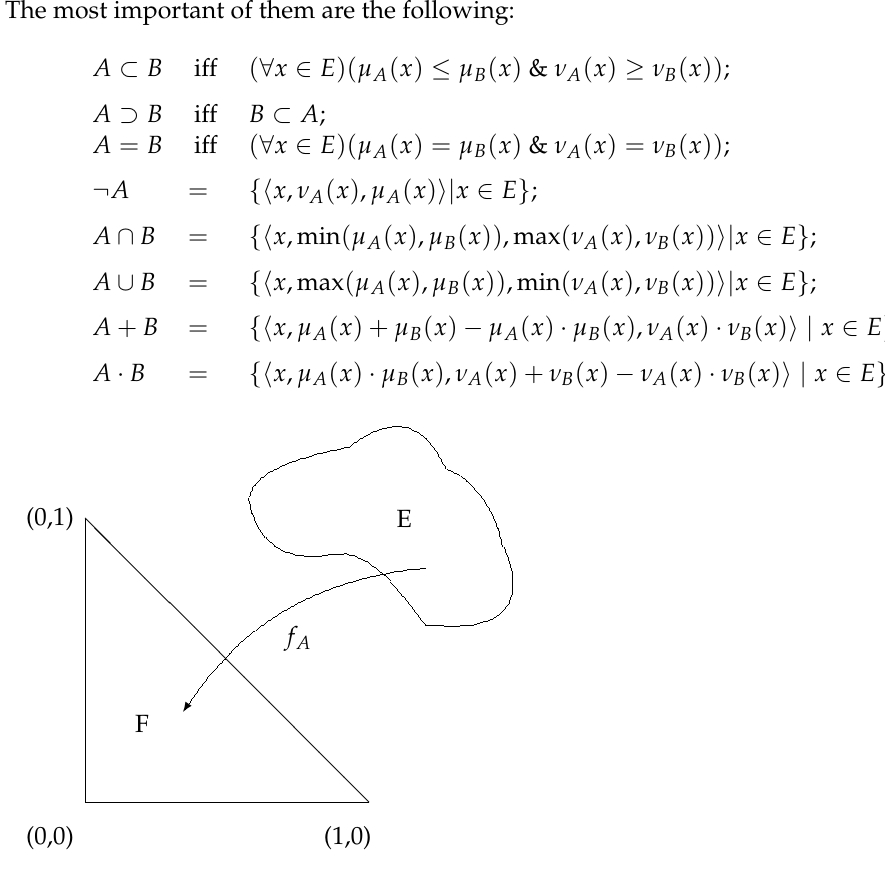
Figure 1. Geometrical interpretation of the elements of a given